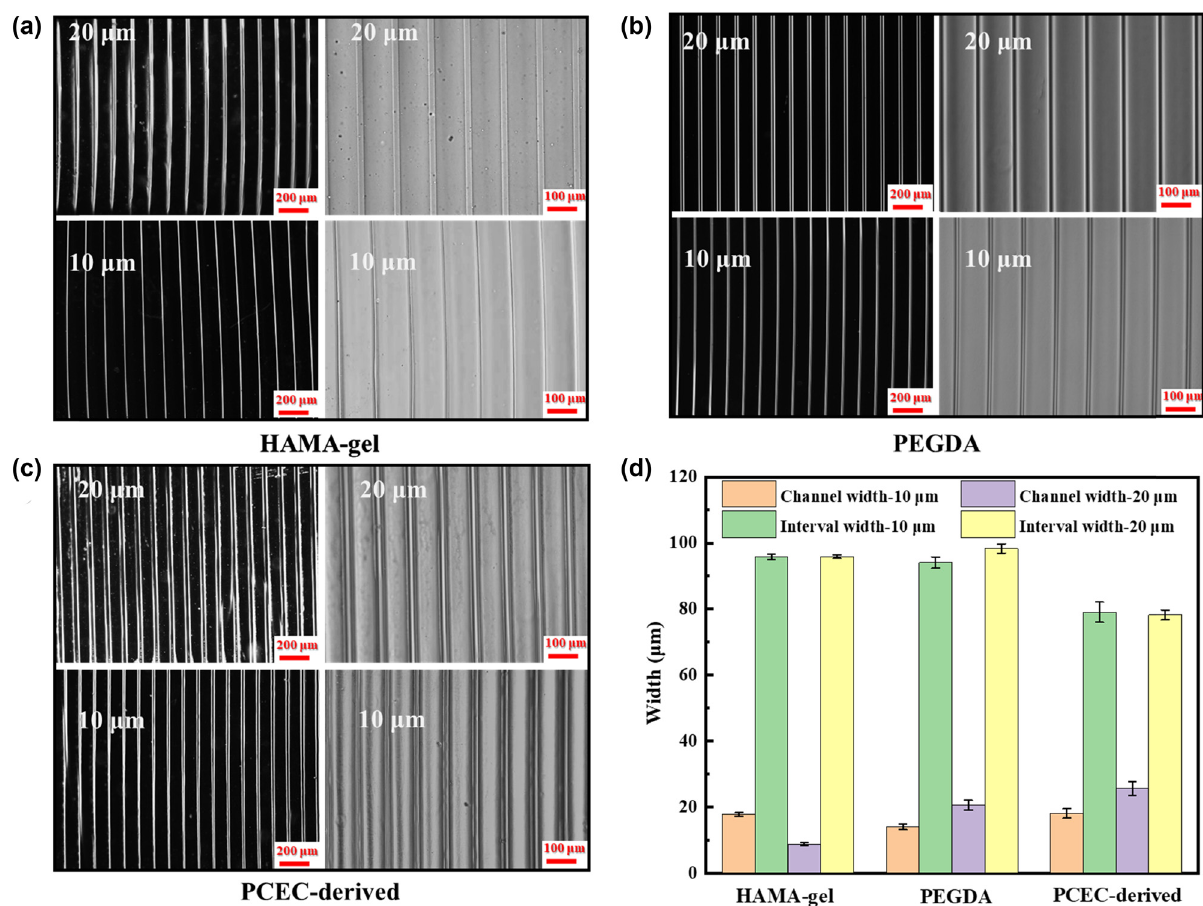
Figure 3: The channel micropatterns on the top surfaces of ( a ) HAMA - gel, ( b ) PEGDA, and ( c ) PCEC - derived materials prepared by photo - lithography and observed by fl uorescence inverted microscope. The gap widths of three materials were designed for 20 and 10 µm, with scale bars of 200 and 100 µm, respectively. ( d ) The regularity of micro - channel on the top surface of the three